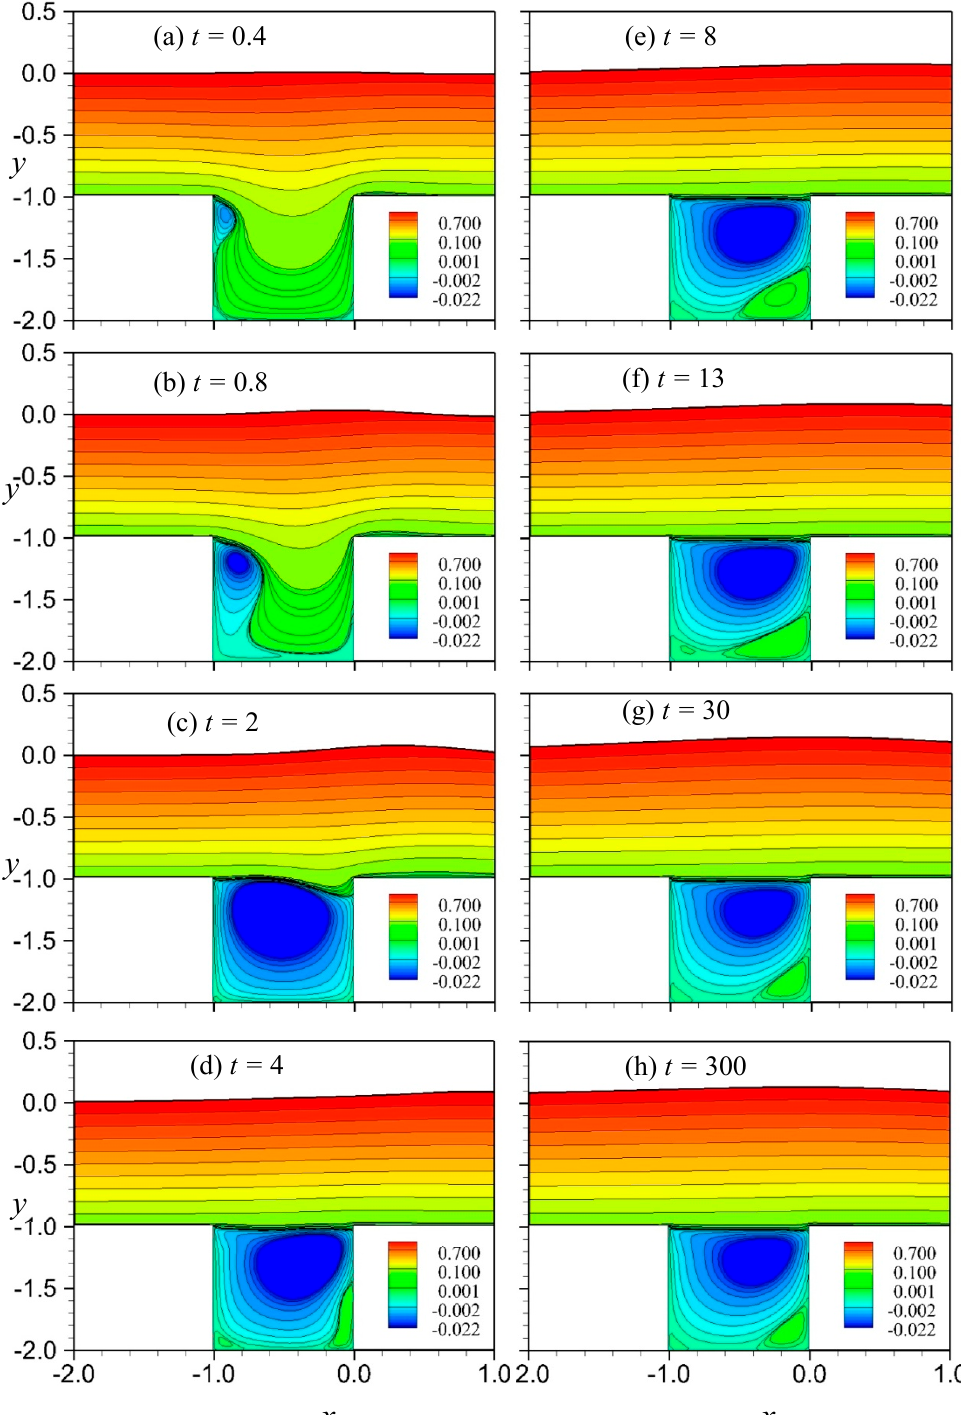
Figure 10. Streamline patterns in a square cavity for Re = 500 and Fr = 1.0 at various phases: ( a ) t = 0.4, ( b ) t = 0.8, ( c ) t = 2, ( d ) t = 4, ( e ) t = 8, ( f ) t = 13, ( g ) t = 30, and ( h ) t =